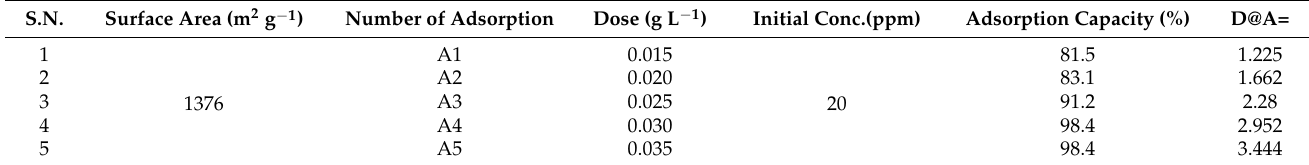
Table 6. Adsorption efficiency of RhB dye at a dose of 0.030 g L − 1 . S.N.